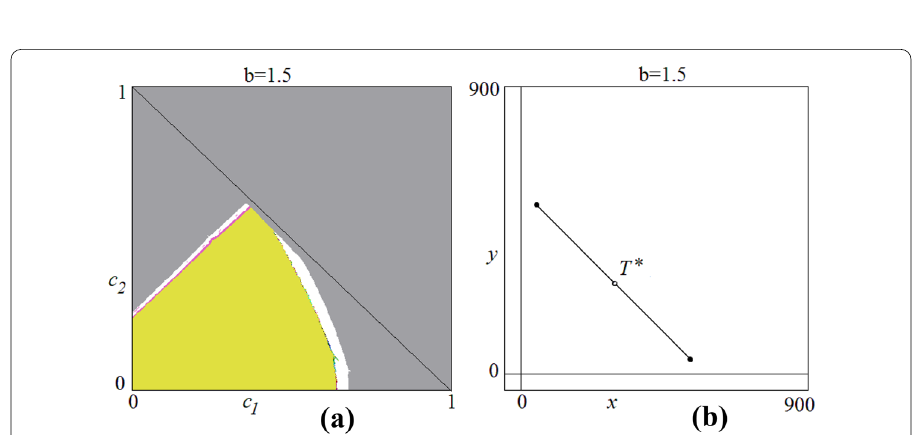
Fig. 6 In a the yellow region represents the stability region of the fixed point T ∗ in the parameter plane 0.8 , G 100, γ 1 , initial condition (400, 400, 400). In b projection of the trajectory of the ( c 1 , c 2 ) at b = = = ( T k , T k nonlinear model in the plane ( x , y ) 1 ) showing the attracting 2-cycle existing at b = 0.8, c 1 = 0.2, = + 0.584618 c 2 =